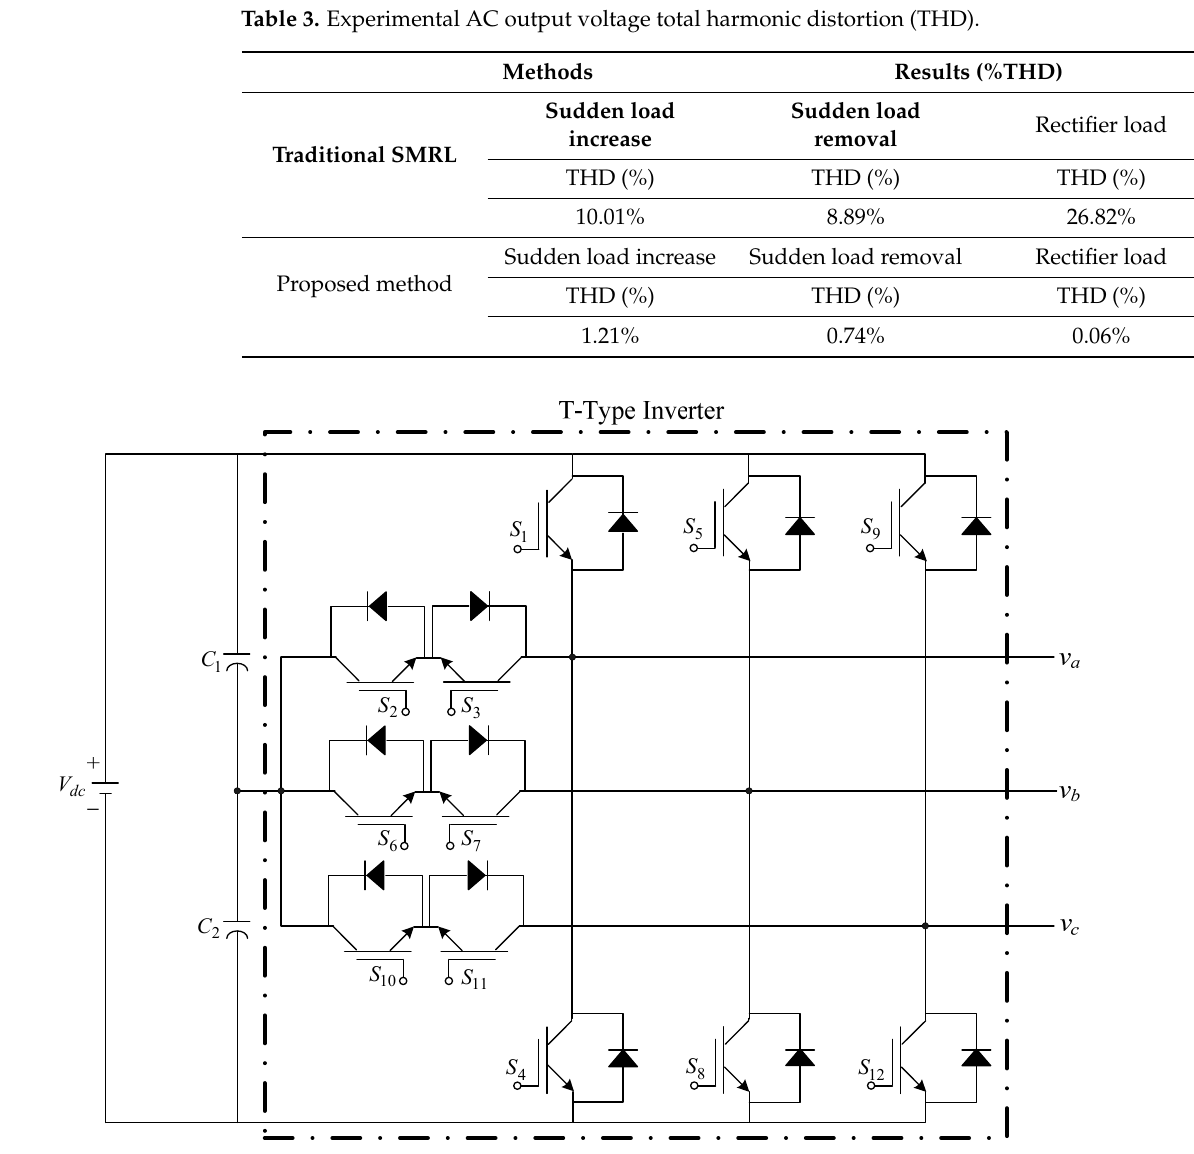
Figure 20. Upcoming research extended to the development of a three-phase T-type inverter.